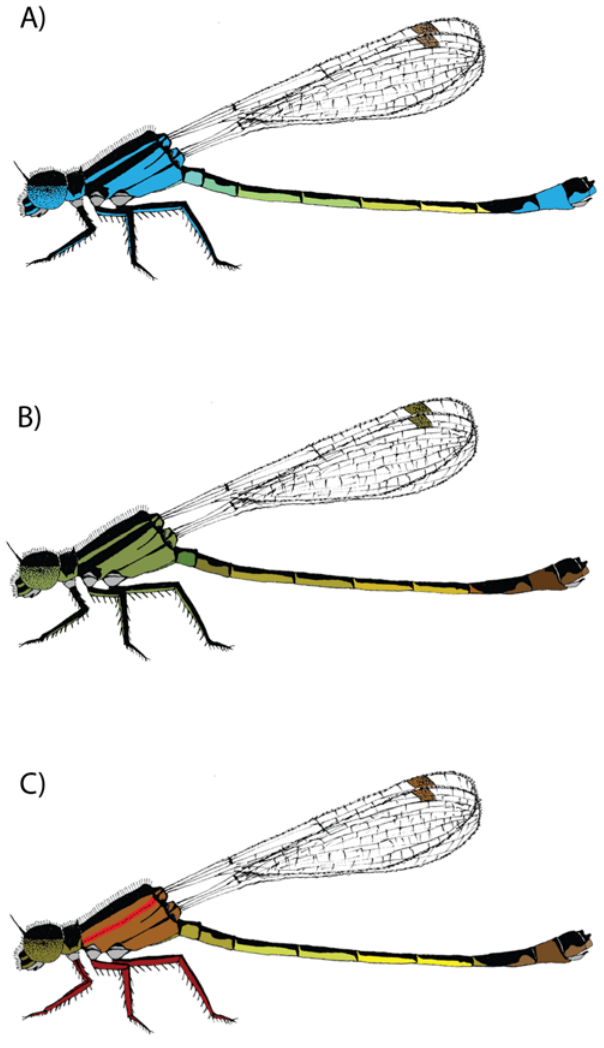
Figure 1. The three female morphs of Ischnuraelegans. Morph is controlled by a single autosomal locus with three different alleles [25]. The six possible different genotypes are subject to a dominancy hierarchy where Androchrome (male mimic) (A) . Infuscans (B) . Infuscans obsoleta (C).